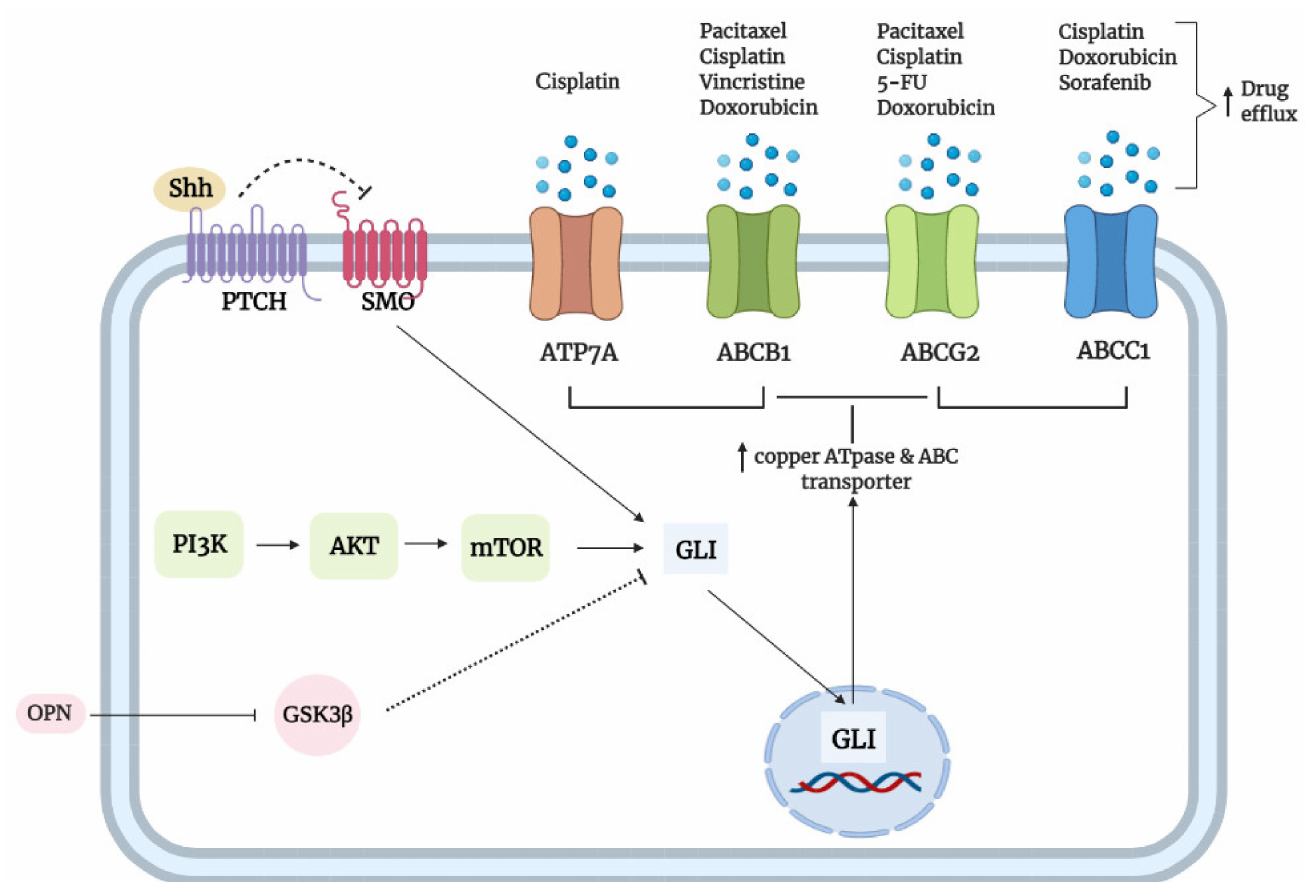
Figure 4. A simplified representation of canonical and noncanonical regulation of GLI in promoting transporter-mediated drug efflux. In the canonical axis, Shh binds to PTCH1, resulting in the alleviation of SMO repression and subsequent GLI activation. In the noncanonical axis, OPN inhibits the negative regulator of GLI, GSK3 β , alleviating the repression of GLI1 function. Activated GLI then translocates into the nucleus, inducing the transcriptional upregulation of copper ATPase and ABC transporters to enhance drug efflux and, consequently, reduce intracellular drug